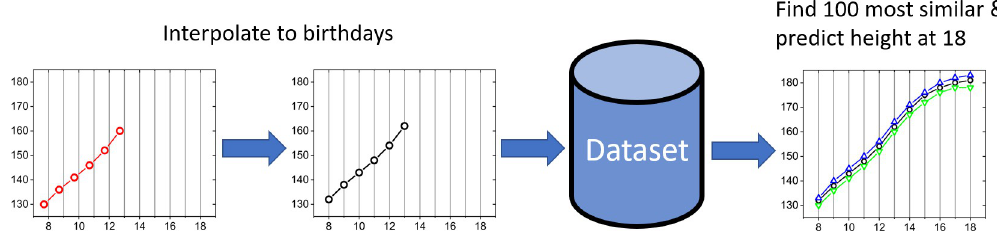
Fig 1. A pipeline showing how a determination of height is made. The input to the model is the time series of heights. We interpolate the values to reflect the heights at the student’s birthday. This set is compared against the database and 100 most similar individuals are then selected, with heights up to the height at the age of 18. The height at the age of 18 for the chosen student is calculated as the sum of the average growths per year. See also Fig 4 for model prediction